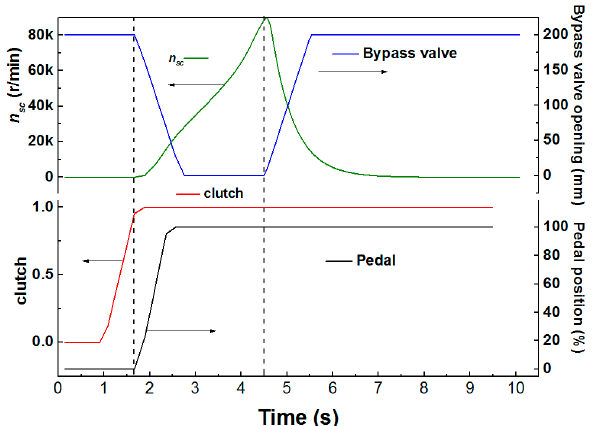
Figure 12. Vehicle starting process simulation results. n sc , bypass valve, pedal, clutch.